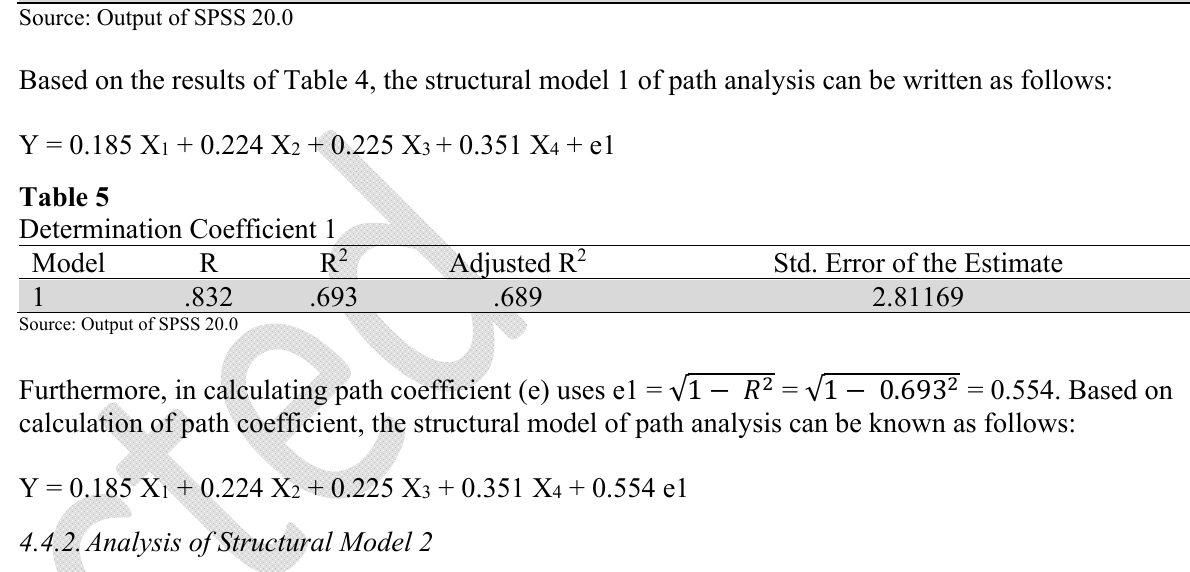
The results of analyzing the first model Model 1 Unstandardized Intercept Product